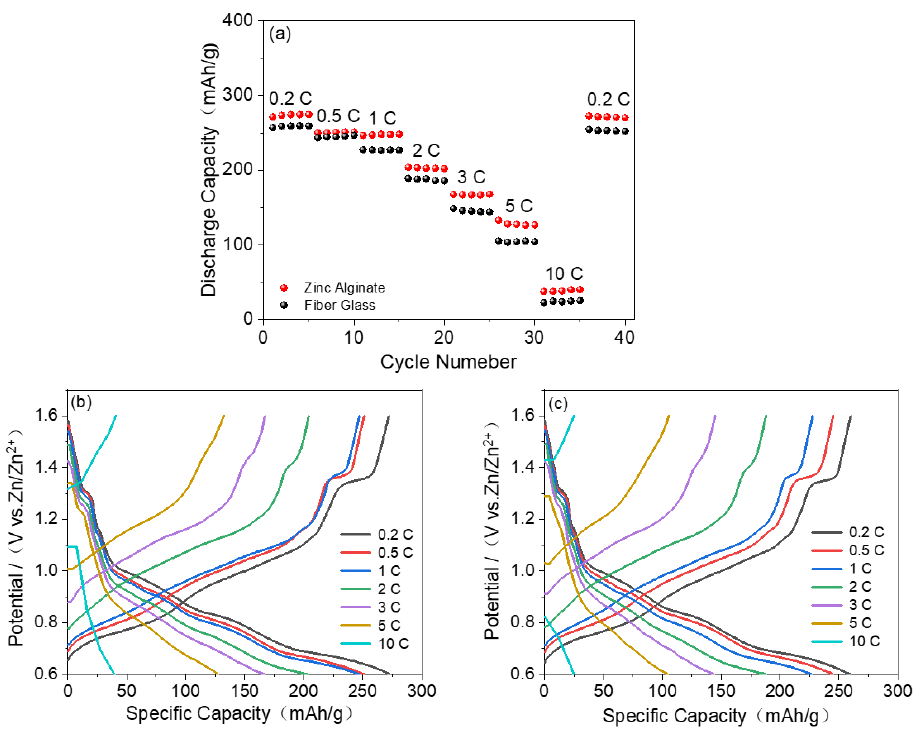
Figure 8. Electrochemical performances of the Zn/ZA-based HGPE/CVO and the Zn/wet glass-fiber separator/CVO at room temperature: ( a ) rate performances; charge–discharge curves of the Zn/CVO cells using ( b ) the ZA-based HGPE and ( c ) the wet glass-fiber separator.